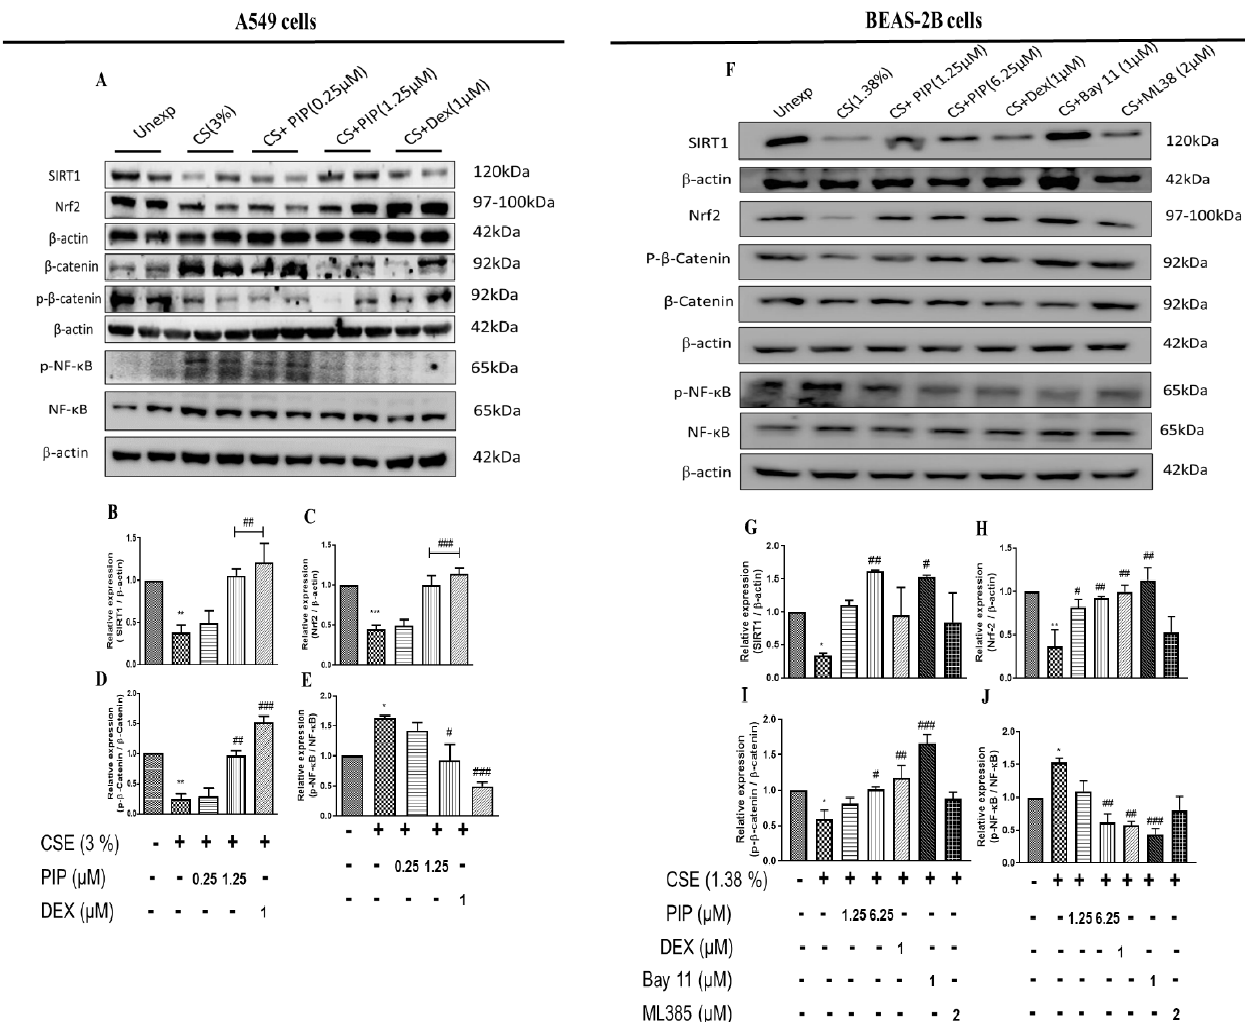
Figure 2. Effect of piperine treatment on expression of oxidative stress, antioxidant, Wnt, and SIRT1 signaling in CSE exposed airway cells: ( A ) Immunoblot images represented the expressions of SIRT1, Nrf2, p- β -Catenin/Total β -Catenin, and p-NF- κ B/Total NF- κ B in A549 cells. Bar graphs represented densitometry analyses of ( B ) SIRT1, ( C ) Nrf2, ( D ) p- β -Catenin/Total β -Catenin and ( E ) p-NF- κ B/Total NF- κ B. ( F ) Immunoblot images represented the expressions of SIRT1, Nrf2, p- β -Catenin/Total β -Catenin, and p-NF- κ B/Total NF- κ B in BEAS-2B cells. Bar graphs represented densitometry analyses of ( G ) SIRT1, ( H ) Nrf2, ( I ) p- β -Catenin/Total β -Catenin and ( J ) p-NF- κ B/Total NF- κ B. The values are expressed as mean ± SEM ( n = 3–4). * p < 0.05, ** p < 0.01 and *** p < 0.001 vs. Unexposed, # p < 0.05, ## p < 0.01 and ### p <0.001 vs. CSE. For A549 cells: CSE: cigarette smoke extract-treated (3 %), CS + PIP (0.25): cigarette smoke extract + 0.25 µM PIP, CS + PIP (1.25): cigarette smoke extract + 1.25 µM PIP, CS + DEX (1): cigarette smoke extract + 1 µM DEX. For BEAS-2B cells: CSE: cigarette smoke extract-treated (1.38 %), CS + PIP (1.25): cigarette smoke extract + 1.25 µM PIP, CS + PIP (6.25): cigarette smoke extract + 6.25 µM PIP, CS + DEX (1): cigarette smoke extract + 1 µM DEX, CS +Bay 11(1): cigarette smoke extract + 1 µM Bay 11, CS +ML385(2): cigarette smoke extract + 2 µM ML-385.